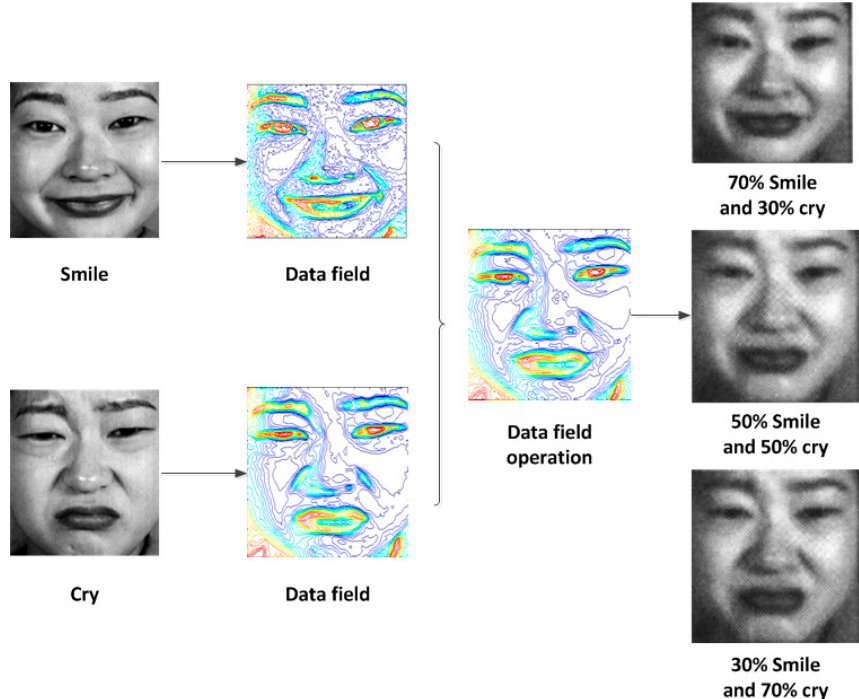
Figure 2. Instruction of data field model [23].